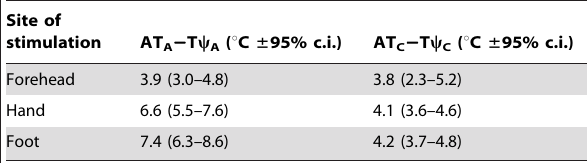
Table 5. Overall estimation of the reaction time artifact.